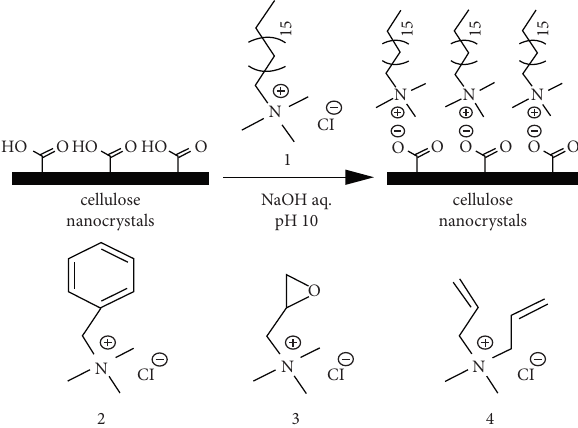
Figure 11: Ionic exchange CNCs reaction modifcation by (1) stearyltrimethylammonium chloride (STAC), (2) phenyl- trimethylammonium chloride, (3) glycidyl trimethylammonium chloride, and (4) diallydimethylammonium chlorideby using NaOH solution at pH 10 for the purpose of altering the hydro- phobicity by dissociating the carboxyl groups in the nanocrystal’s surface area [183]. Copyright and permission from Springer